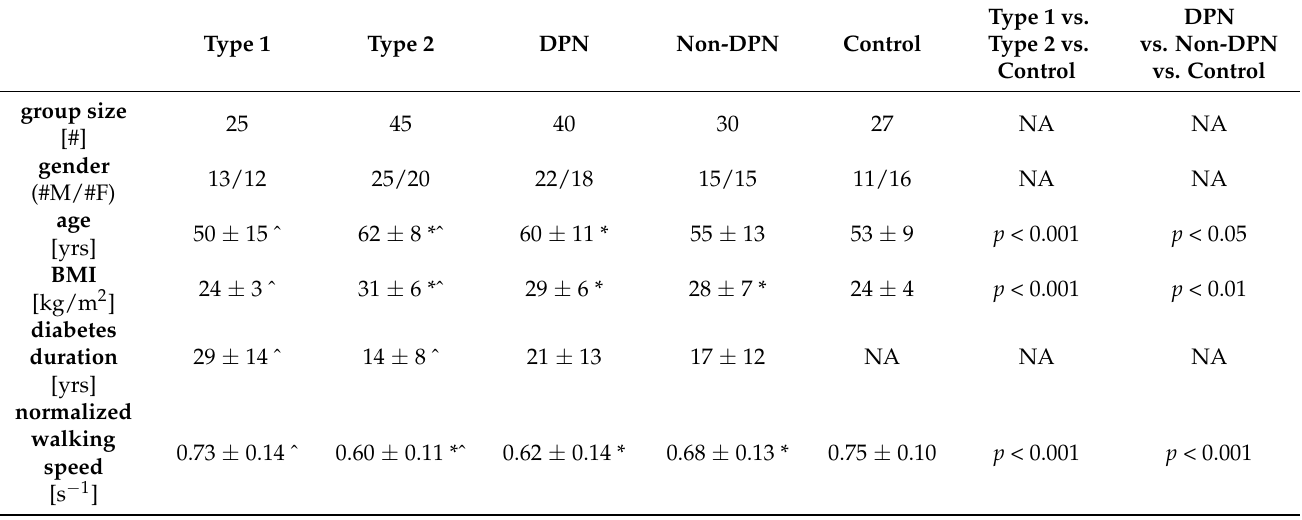
Table 1. Size and gender distribution in type 1, type 2, neuropathic, non-neuropathic and control groups. Mean ( ± std) of the four independent variables used as covariates are reported for each group. Kruskal–Wallis statistical differences are shown in the last two columns. * denotes post hoc pairwise statistically significant difference between any diabetic group and control ( p < 0.05); ˆ denotes post hoc pairwise statistically significant difference between two diabetic groups ( p <